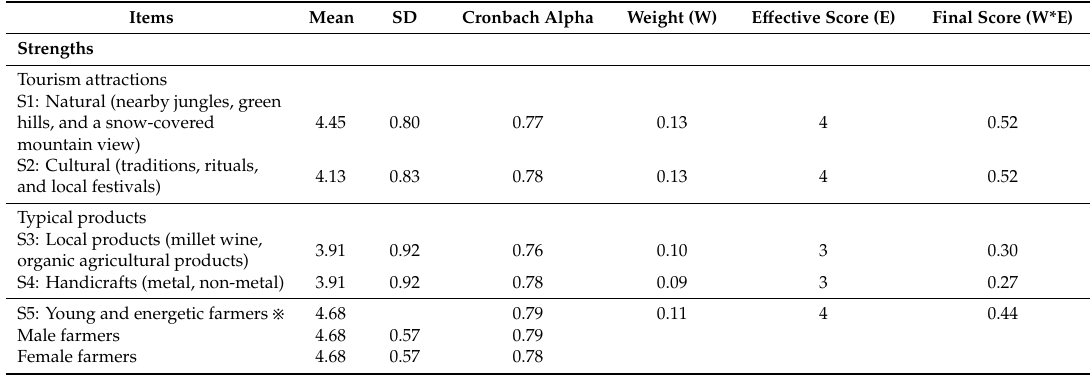
Table 3. The internal factor estimation matrix